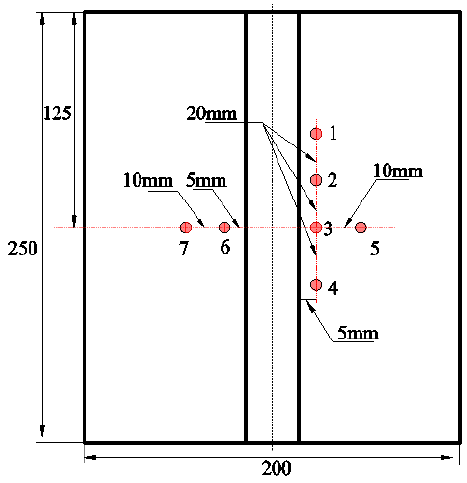
Figure 5. Test points after the initial welding.